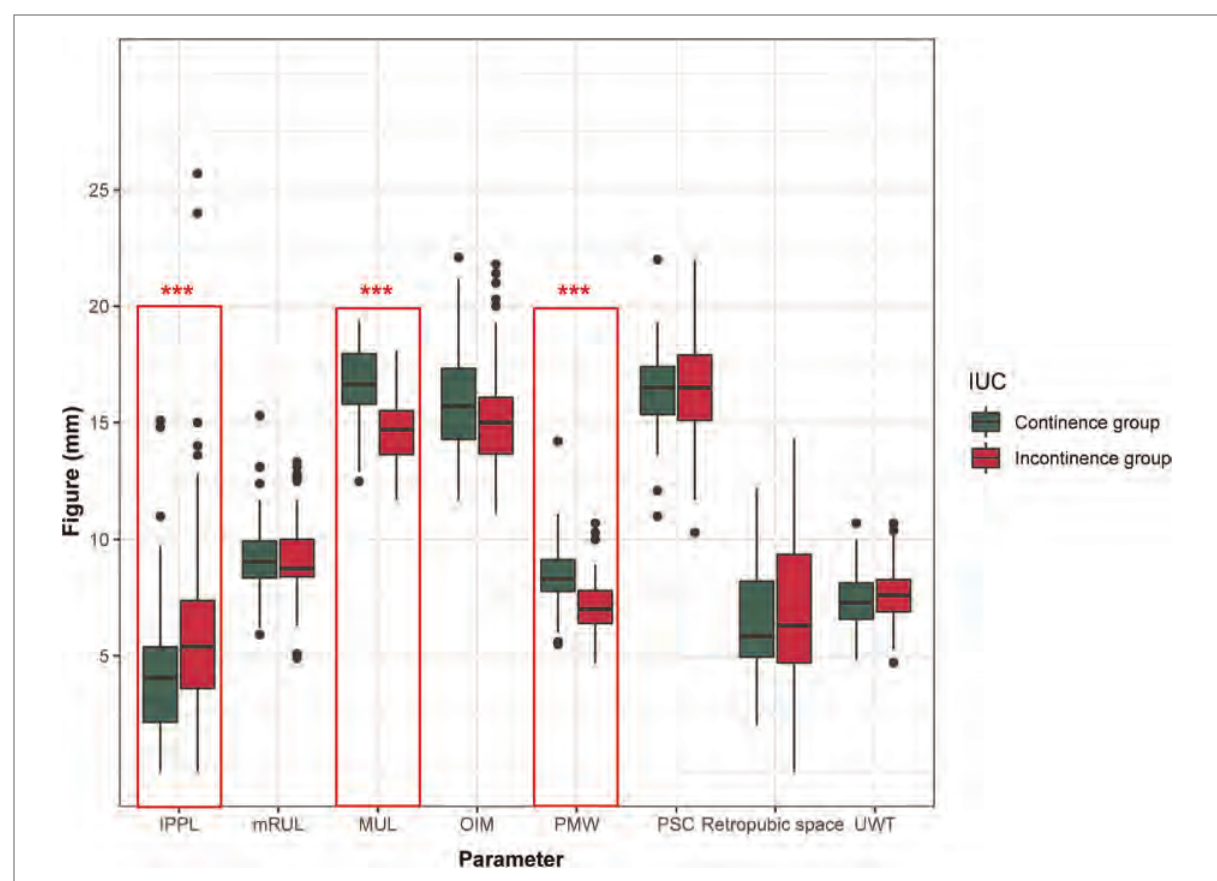
FIGURE 3 Preoperative urethral and pelvic anatomic parameters in continence vs. incontinence group immediately after LRP. IPPL, Intravesical prostatic protrusion length; MUL, membranous urethral length; PMW, Puborectalis muscle width; UWT, urethral wall thickness; PSC, peri-urethral sphincter complex; OIM, obturator internus muscle; mRUL, Minimal residual membranous urethral length. * p <0.05; ** p <0.01; *** p